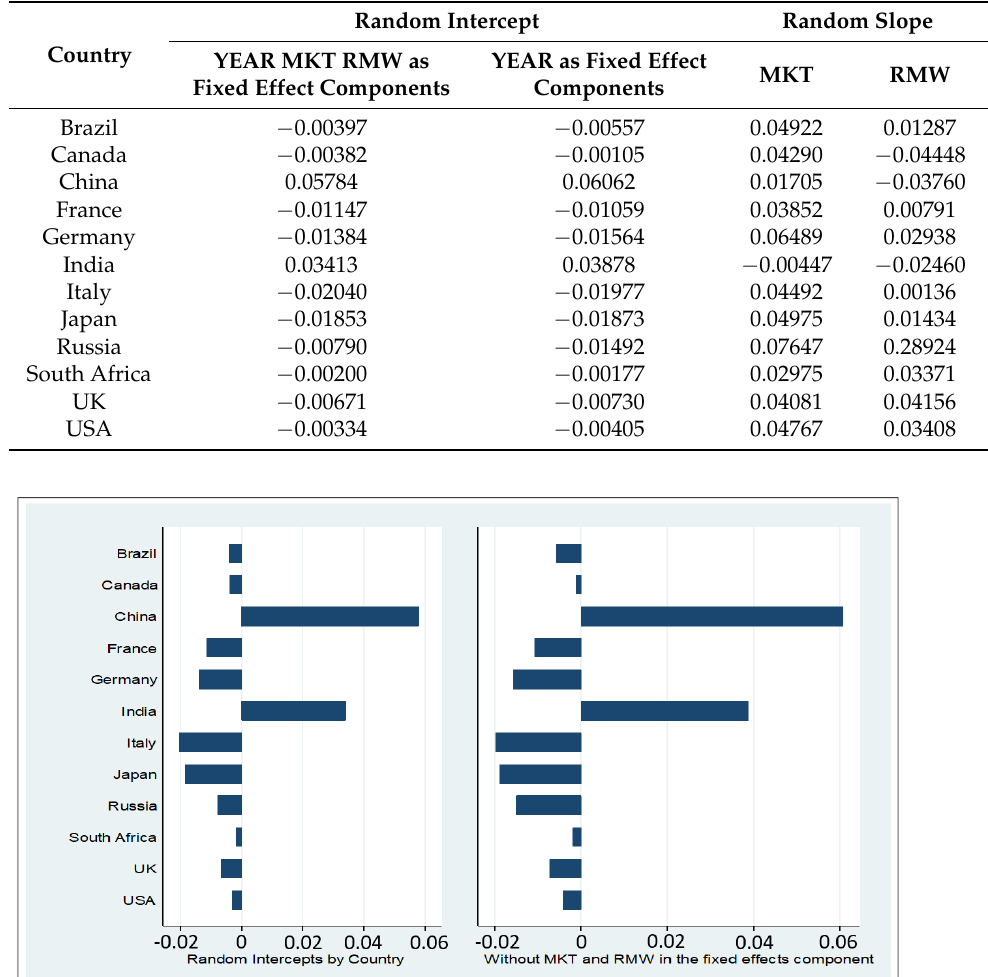
Table 11. Expected Values of Intercepts of Random Effects by Country Estimated by Linear Trend Models of Explanatory Variables YEAR, MKT and RMW in the Fixed Effects Component and without MKT and RMW in the Fixed Effects Component, but rather in the Random Effects of the Slopes.